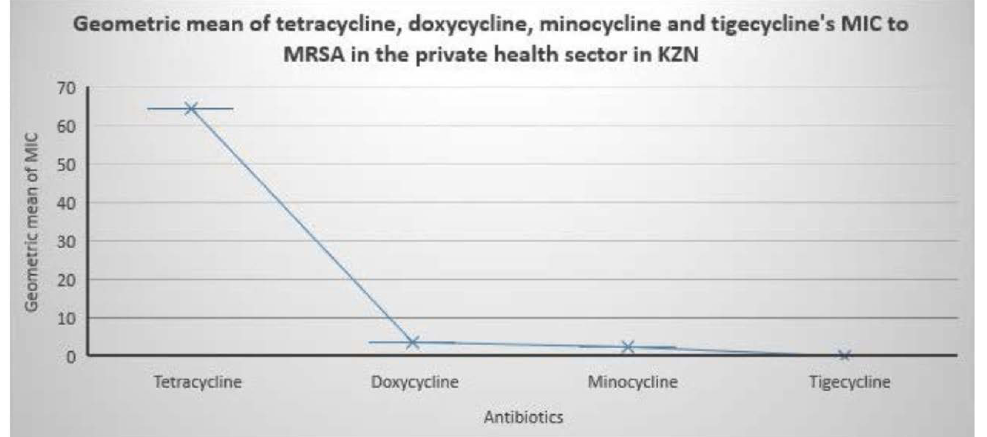
Fig. 2. Geometric mean of tetracycline, doxycycline, minocycline and tigecycline MIC to MRSA in the private health sector in